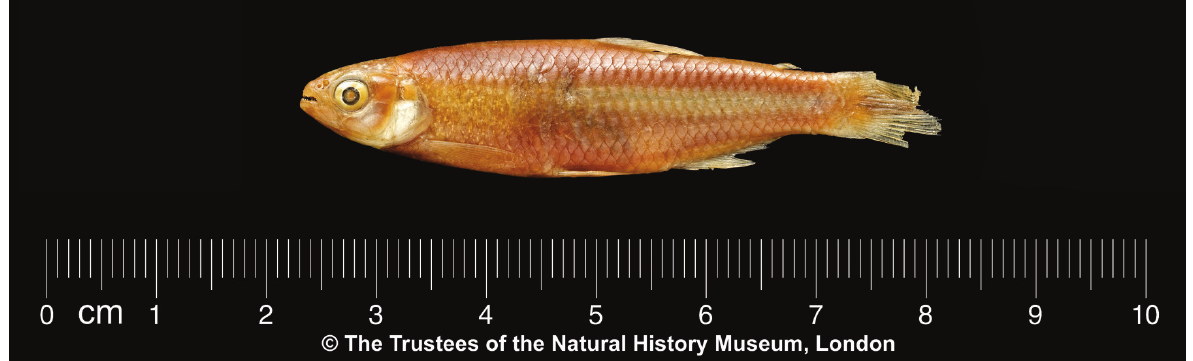
Figure 2. Lectotype of Aphyocharax alburnus : BMNH 1869.5.21.10. Photographed by Harry Taylor.